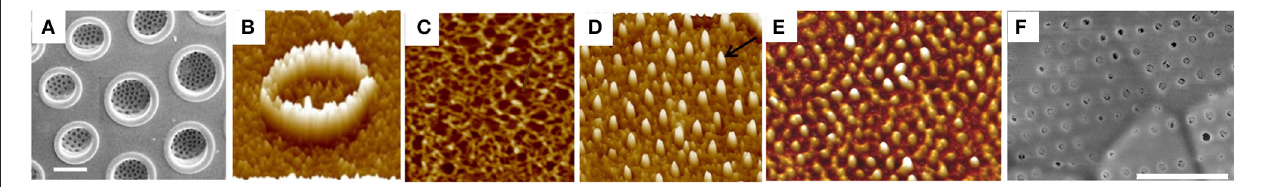
FIGURE 5 | Characterization of the AFIM, or insoluble organic matrix from Coscinodiscus radiatus . (A) SEM of Proximal valve surface, highlighting the large openings of the foramina. Scale bar = 5 µ m. (B) AFM of region of foramina in the AFIM. (C) Fibrous structure of AFIM from proximal surface. (D) AFM of AFIM from a girdle band, showing projections that define pores. (E) AFM of AFIM from the valve of Stephanopyxis turris . (F) SEM of proximal valve surface of S. turris . Scale bar = 1 µ m. Scan sizes are (B) = 1 µ m, (C) = 1.2 µ m, (D) = 2 µ m, (E) = 3.6 µ m. From Tesson and Hildebrand (2013), reproduced under the Creative Commons